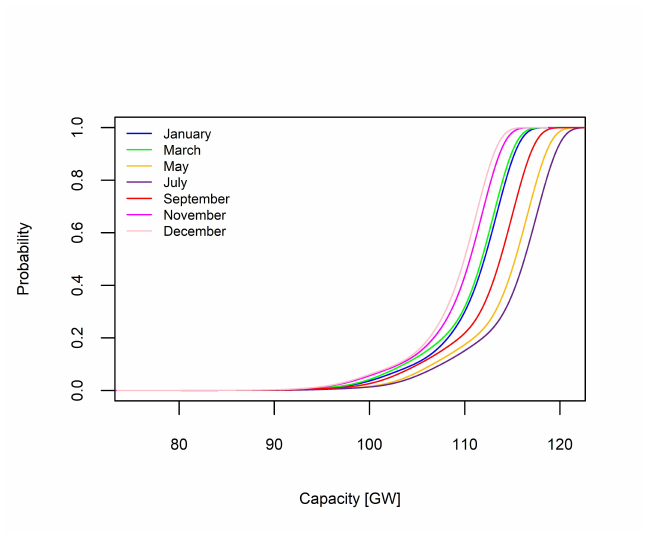
Figure 3. Graph representation of accumulated probabilities of COPT for 2019 for the first day of the selected